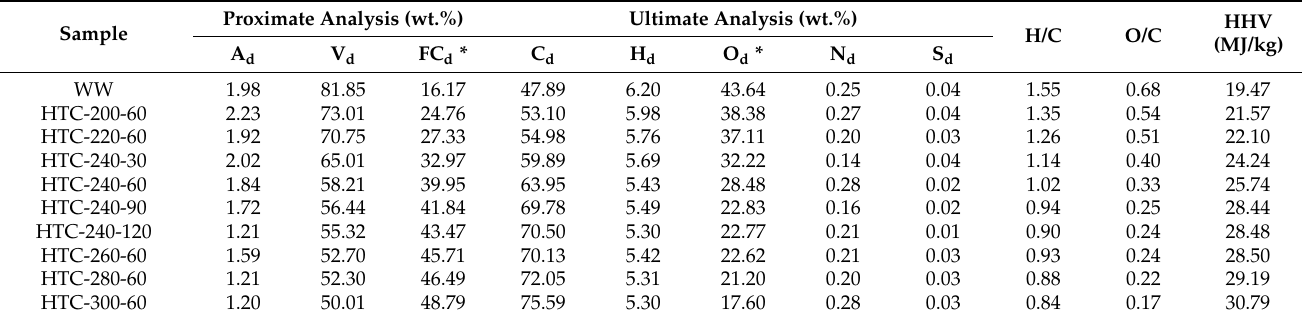
Table 1. Proximate analysis and ultimate analysis of WW and hydrochar.